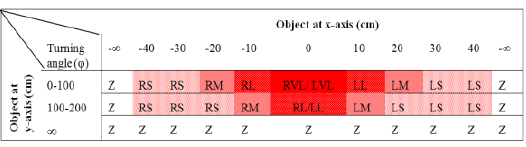
Table 2. The relation between turning angle and detected object